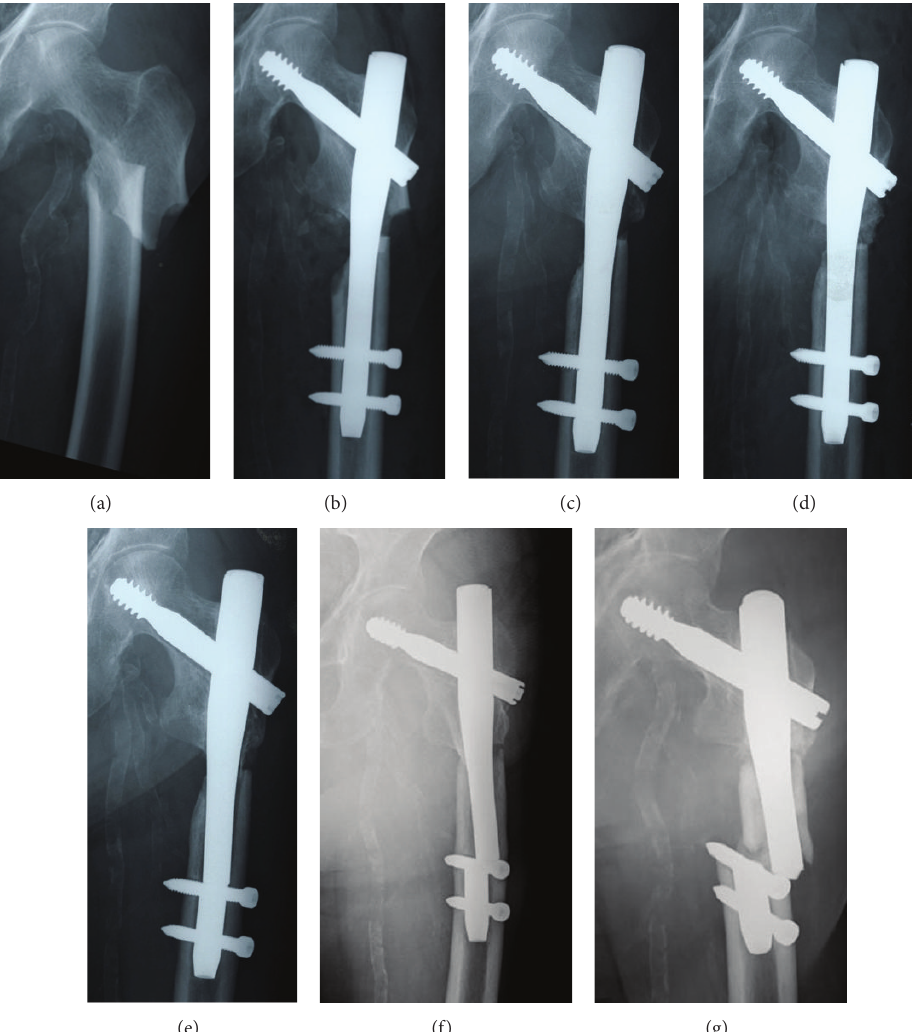
Figure 1: Consecutive history before surgery at our hospital. (a) Subtrochanteric fracture, (b) initial surgery, (c) nonunion at 10 months after surgery, (d) autologous bone grafting, (e) nail breakage at 2 months after bone grafting, (f) 24 months after bone grafting, (g) fracture at nail breakage 26 months after bone